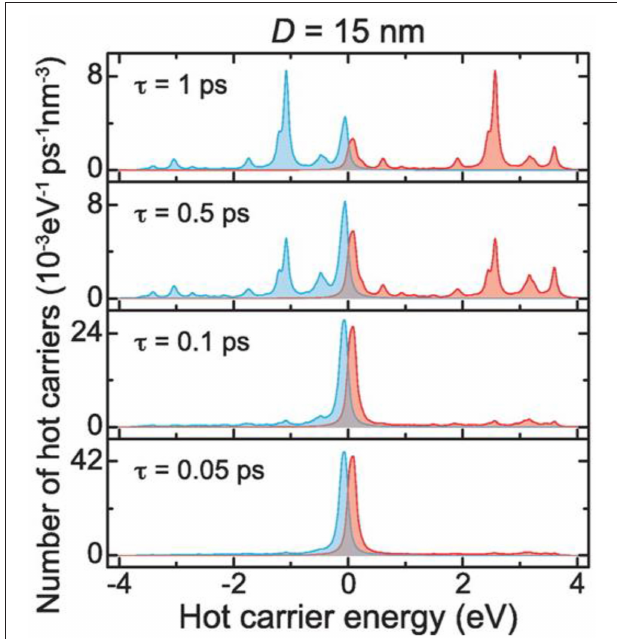
FIGURE 2 | Hot carrier distributions per unit time and volume as a function of energy, calculated for a 15nm diameter Ag nanoparticle. Hot electrons and hot holes are plotted as the blue and red lines, respectively, with the Fermi level set at the zero energy. The stacked plots show the changes in the hot carrier distributions for relaxation lifetimes from 0.05 to 1.0 ps. An incident photon energy of 3.65eV was used. Adapted with permission from Manjavacas et al. (2014). Copyright 2014 American Chemical